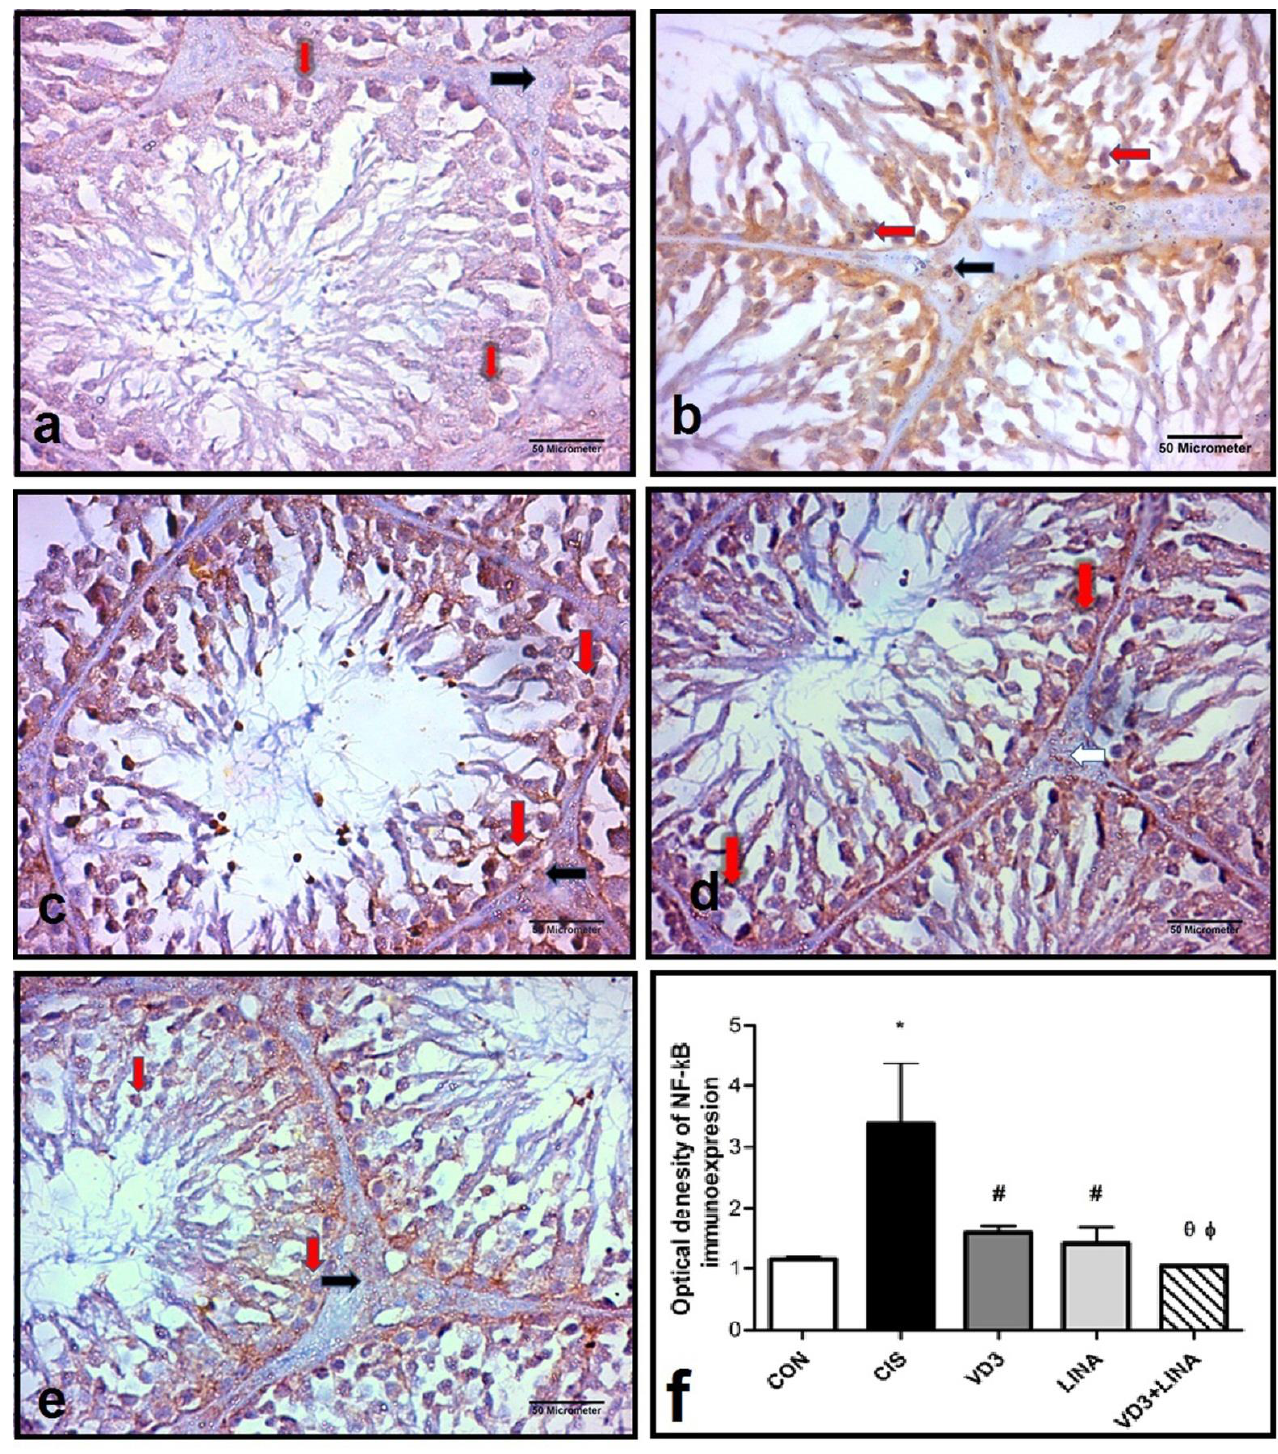
Figure 5. Immunohistochemical staining of NF- κB in testicular sections from experimental groups. NF- κB appeared as brown cytoplasmic and nuclear immunoreactions (avidin biotin peroxidase stain with Hx counter stain ×400, scale bar = 50 μm); ( a ): CON group showing weak nuclear and cytoplasmic immunoreaction for NF- κB spermatogenic cells (red arrows) and interstitial cells of Leydig (black arrow); ( b ): CIS group showing strong nuclear and cytoplasmic immunoreaction for NF- κB in spermatogenic cells (red arrows) and interstitial cells of Leydig (black arrows), as compared with that in the CON group; ( c ): VD3 group showing weak nuclear and cytoplasmic immunoreaction for NF- κB in in spermatogenic cells (red arrows) and interstitial cells of Leydig (black arrow); ( d ): LINA group showing weak nuclear and cytoplasmic immunoreaction for NF- κB